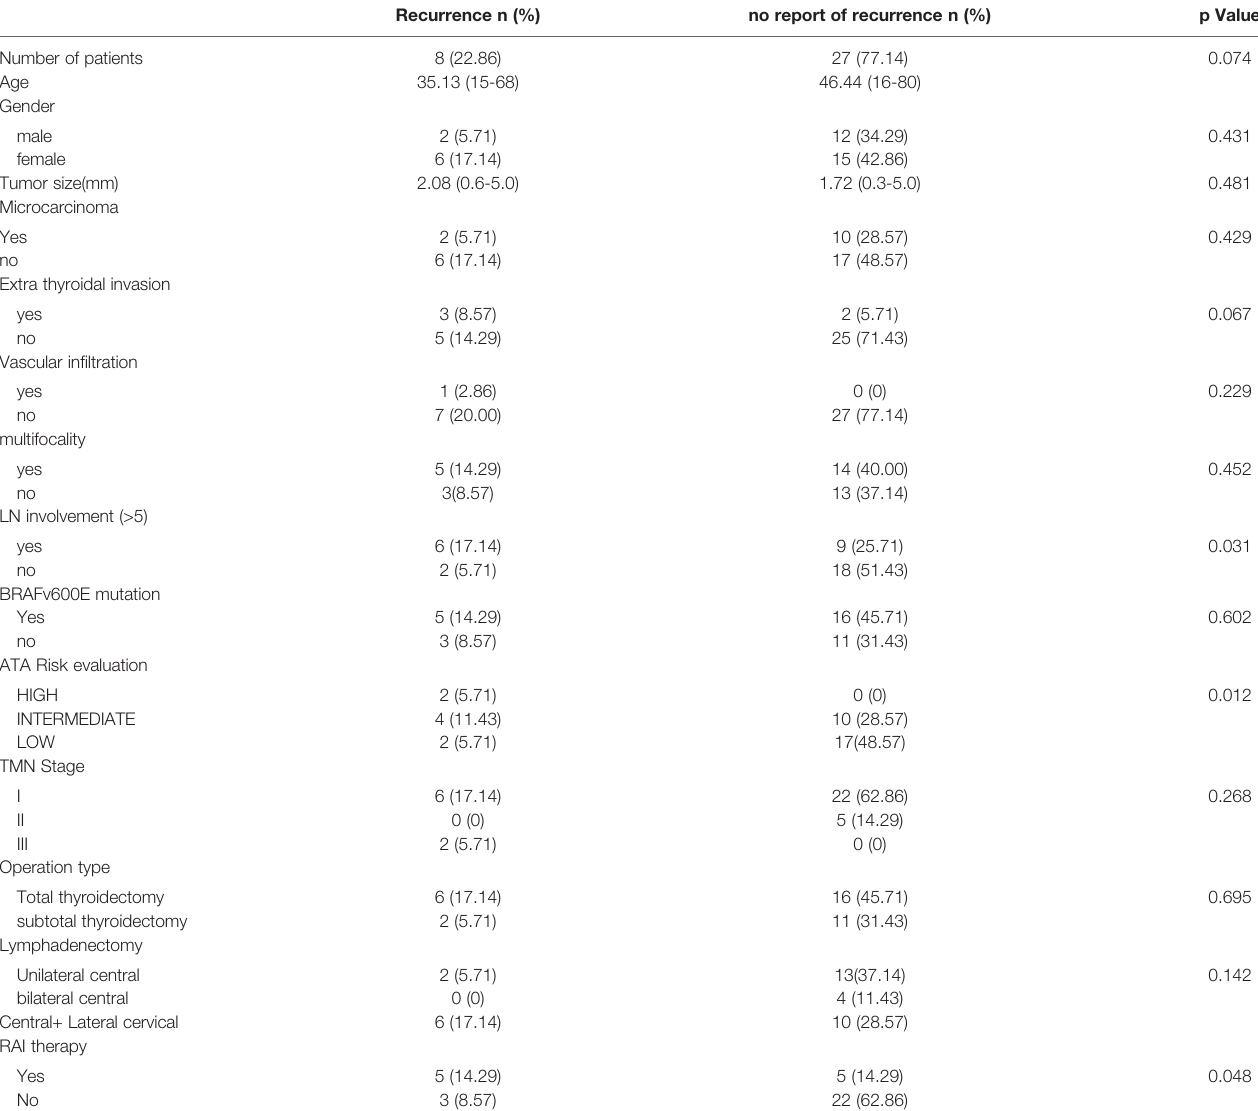
TABLE 1 | Clinical characteristic of patients with PTC in study